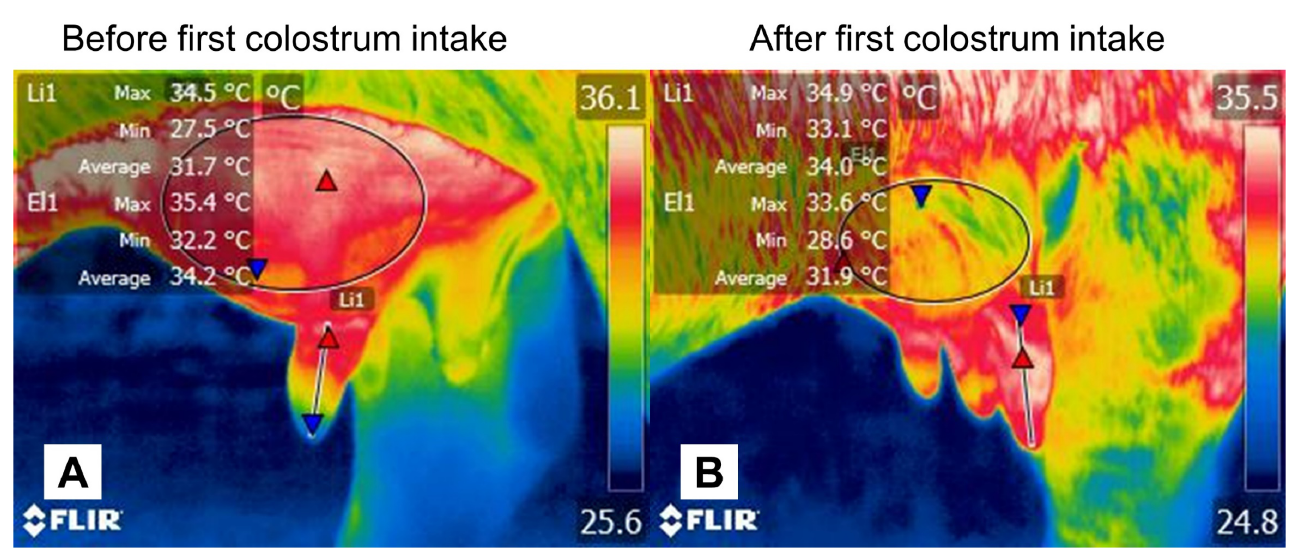
Figure 6. Microcirculatory changes in a water buffalo ( Bubalus bubalis ) udder before and after colostrum ejection. ( A ) Lateral region of the udder before the first colostrum intake. The average temperature of the teat (Li1) is 31.7 °C, a temperature that is lower than the average recorded in the body of the gland, at 34.2 °C. This could be due to the effect of estrogens and the congestion of the mammary gland (MG) before feeding the newborn. ( B ) After the first colostrum intake, a shift in the average temperatures is observed, where the teat has a 2 °C higher value, and the body of the MG has an average temperature 2.3 °C lower than the one observed in image ( A ). This effect can be attributed to the effect of colostrum ejection, where the calf stimulates the teat, suckles, and requires a larger supply from this zone. The maximum temperature is illustrated with a red triangle and the minimum with a blue one. Thermal images obtained using a FLIR thermal camera.